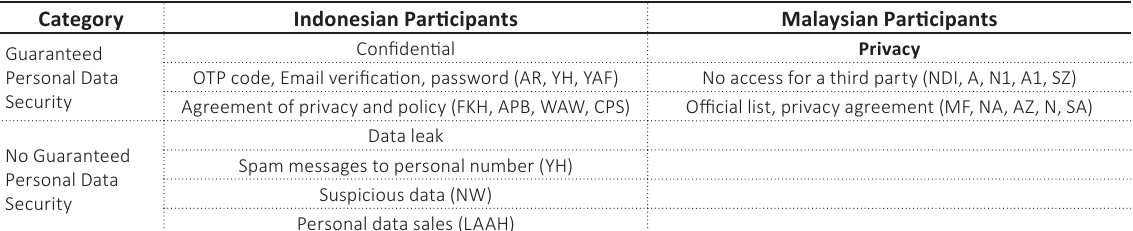
Source: Data owned and processed by the